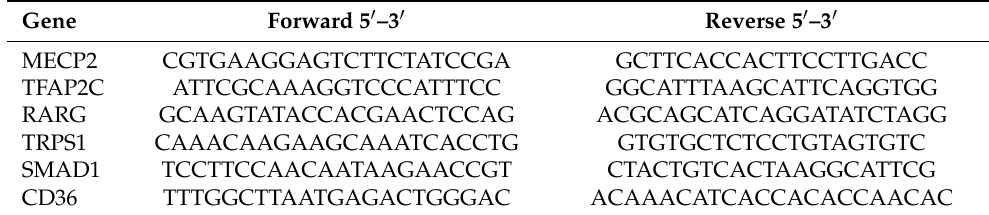
Table 1. Sequences of gene-specific primers used in this